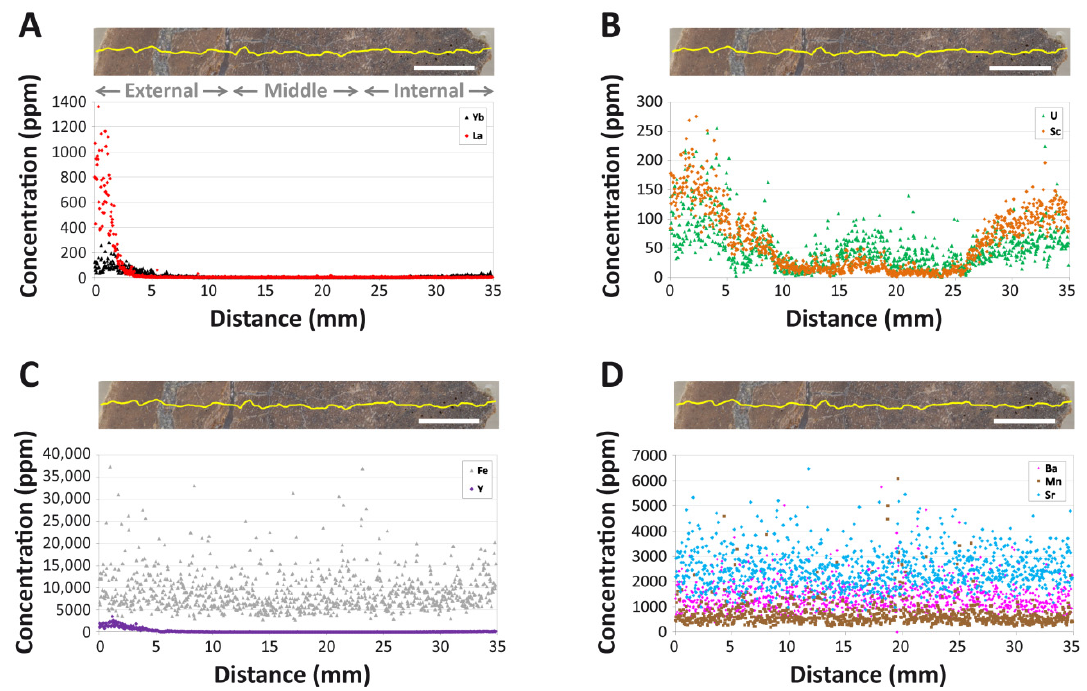
Figure 2. Intra-bone concentration gradients of various elements in the tibia of MOR 2598. ( A ) Lanthanum (La) and ytterbium (Yb). ( B ) Scandium (Sc) and uranium (U). ( C ) Iron (Fe) and yttrium (Y). ( D ) Barium (Ba), manganese (Mn), and strontium (Sr). Note the different concentration scales for each panel. The laser track is denoted by the yellow line in each bone cross section. Gray text labels in ( A ) span the approximate regions considered as the ‘external’, ‘middle’, and ‘internal’ cortices. Scale bars, in white over bone images, each equal 5 mm.